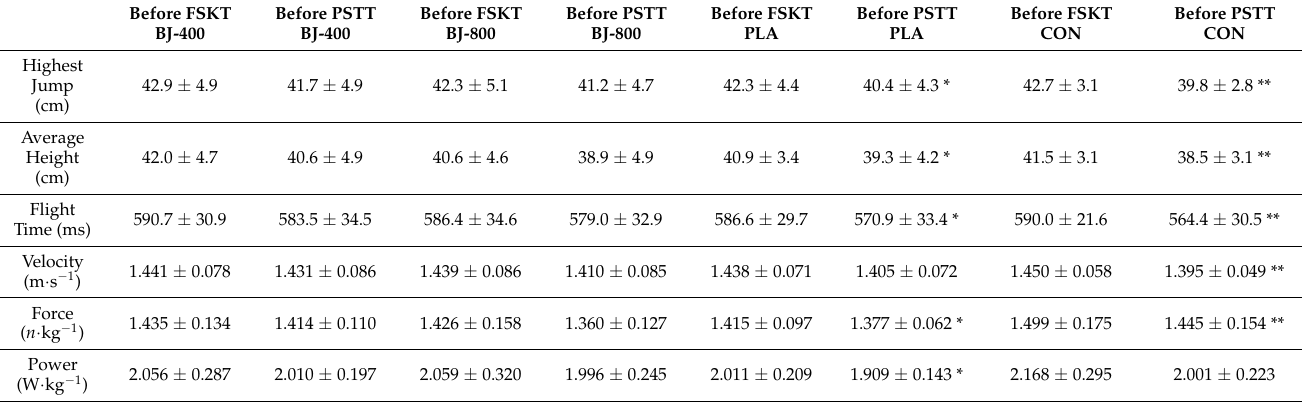
Table 1. Countermovement jump performance before the different experimental conditions.